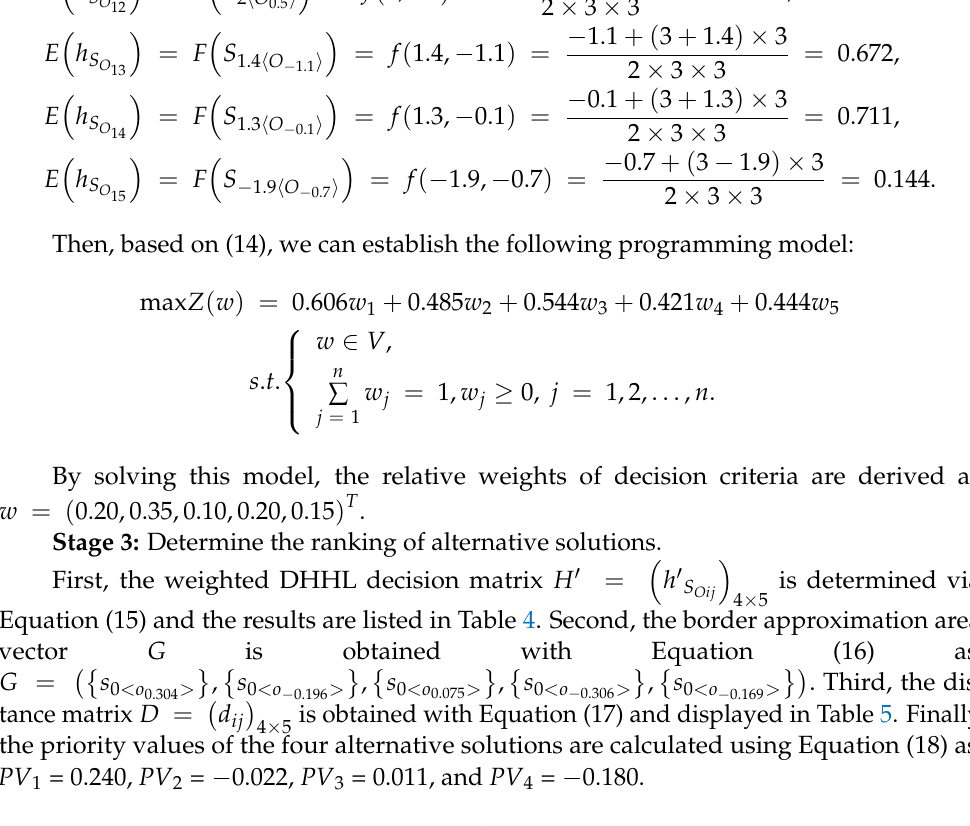
Table 4. The weighted DHHL decision matrix H (cid:48) .